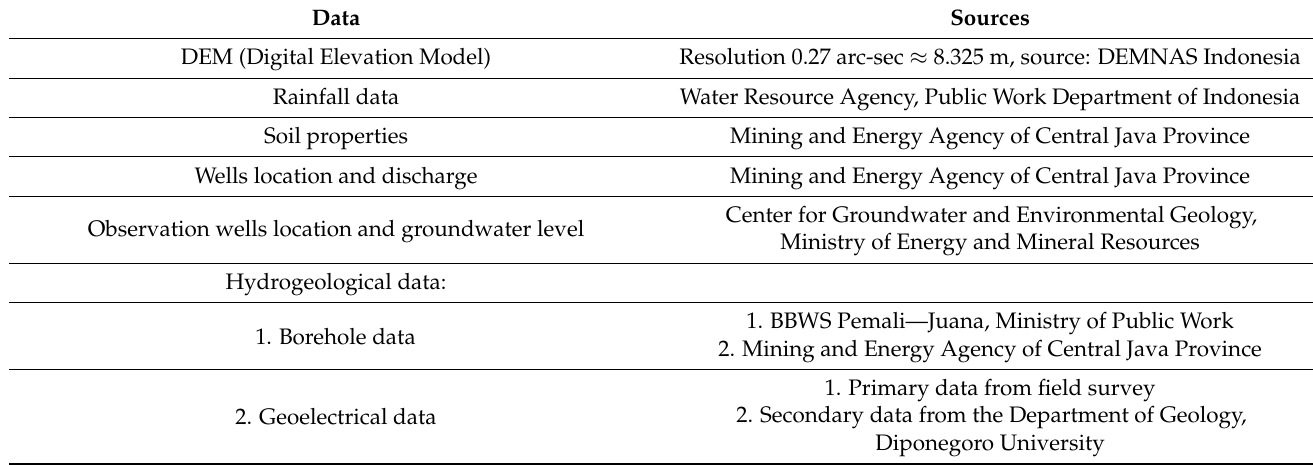
Table 1. Data source for the groundwater modeling in Semarang City used in